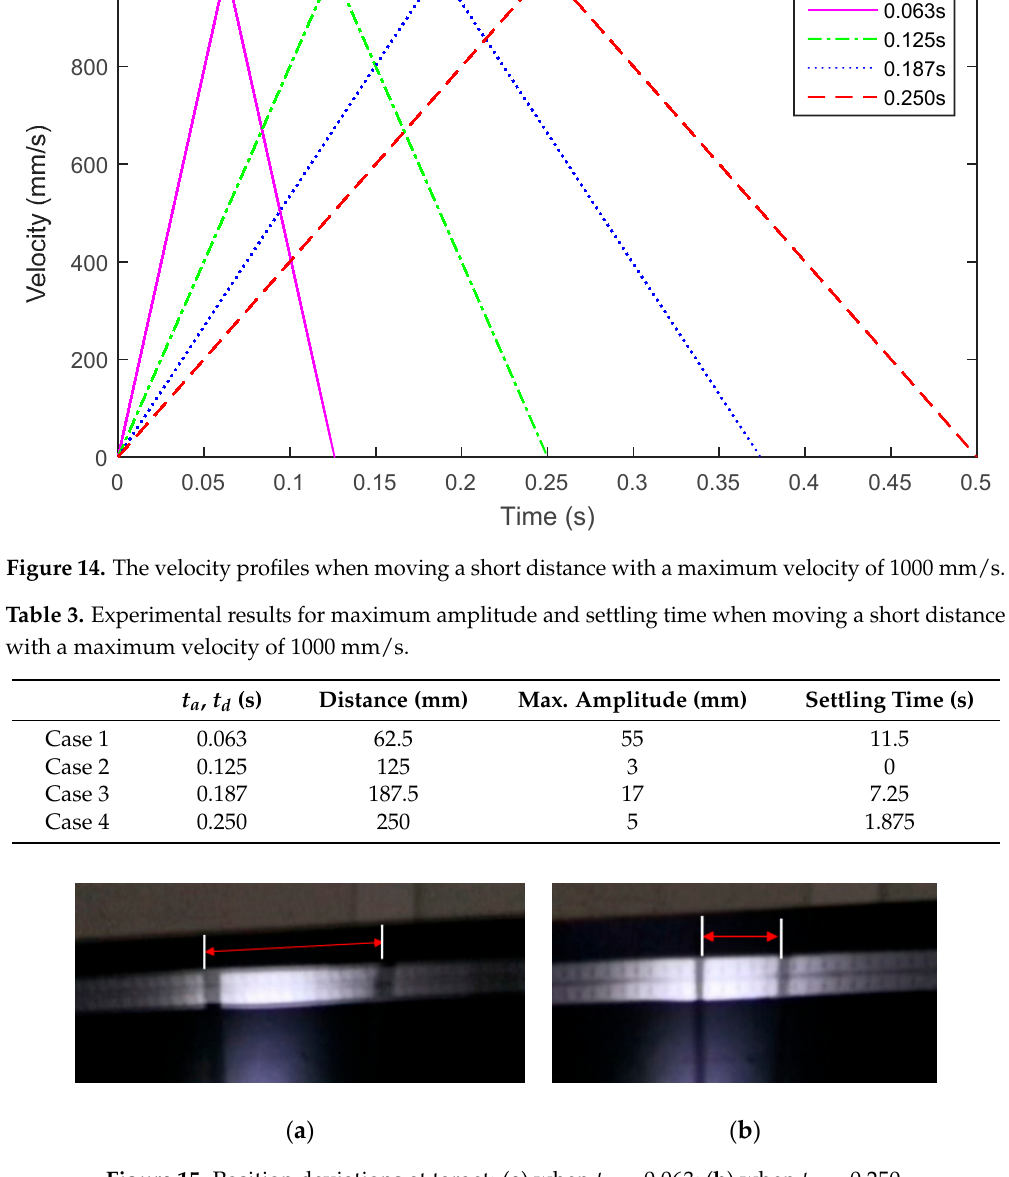
Figure 16. The experiment where the robot linearly moved while the configuration changed: ( a ) initial position; ( b ) final position. The velocity profiles of the robot are shown in Figure 17. All four cases were tested in the experiment. The results in terms of amplitude and settling time for all cases are listed in Table 4. Figure 18 shows photos of the maximum deviation at the target. The amplitude and settling time in cases 2 and 4, in which the acceleration/deceleration time was a multiple of the vibration period of the natural frequency, were smaller than those in cases 1 and 3. The best case in terms of the suppression of residual vibration was case 2, wherein the duration of acceleration was identical to the vibration period. Comparing the best result with the worst result, the amplitude is reduced by 73.1% and the settling time is reduced by 6.125 s.